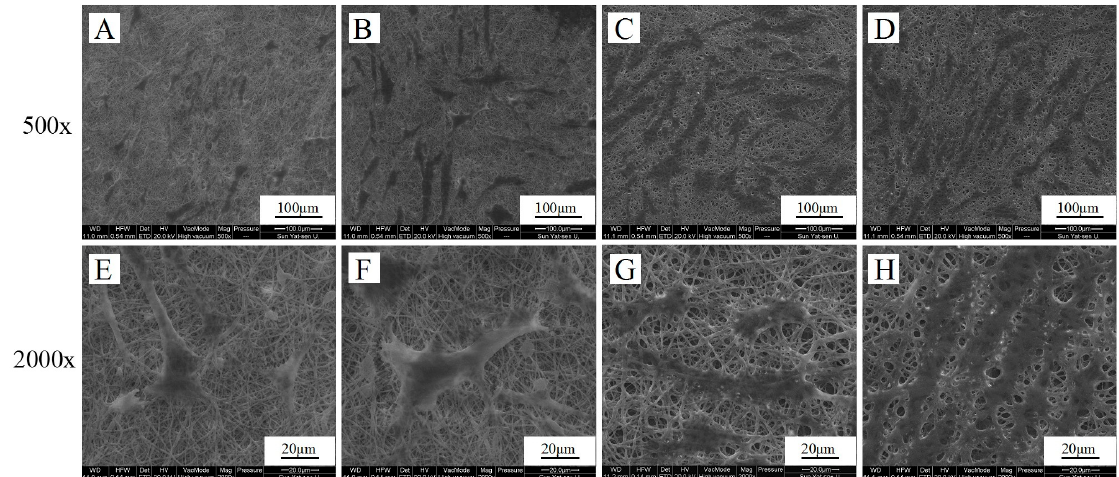
Figure 8. Morphology of human PDLSCs cultured on pure zein ( A , E ); zein/gelatin-1 ( B , F ); zein/gelatin-2 ( C , G ); and zein/gelatin-3 ( D , H ) for 6 days at different magnifications.